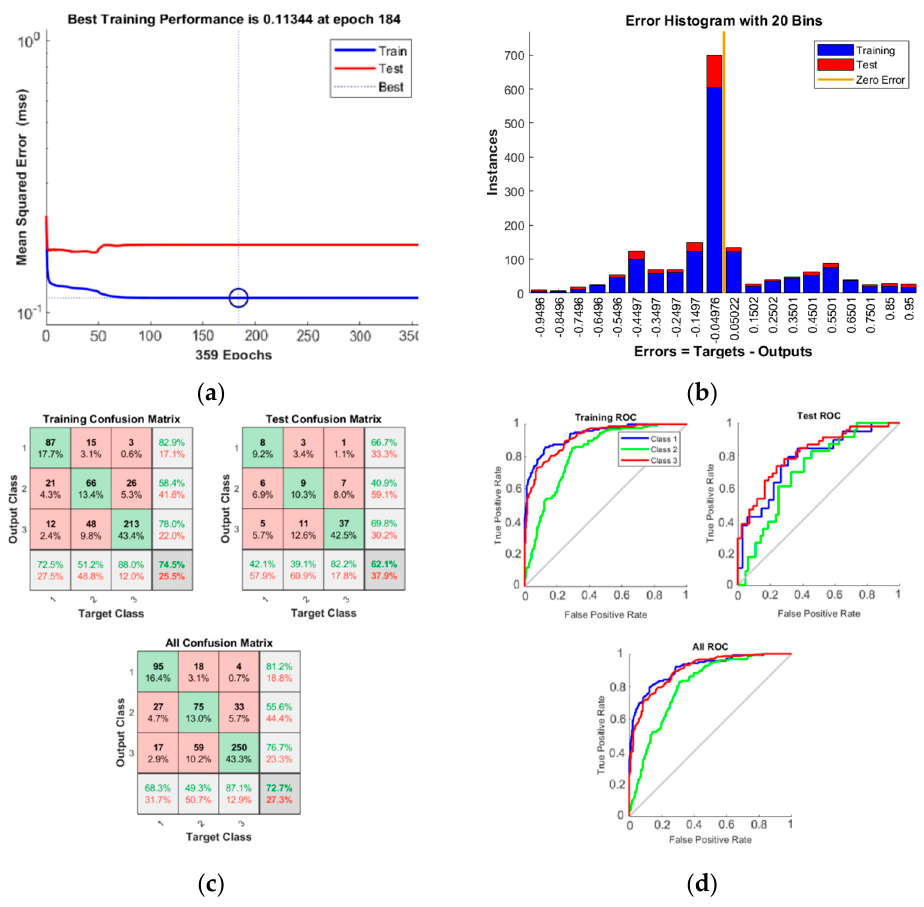
Figure 4. Results of the pattern recognizer ANN training: ( a ) Best training performance with a MSE of 0.1134; ( b ) Error histogram of the dataset entries; ( c ) Confusion table of ANN output relative to the desired target; ( d ) Receiver Operating Characteristic of the ANN.